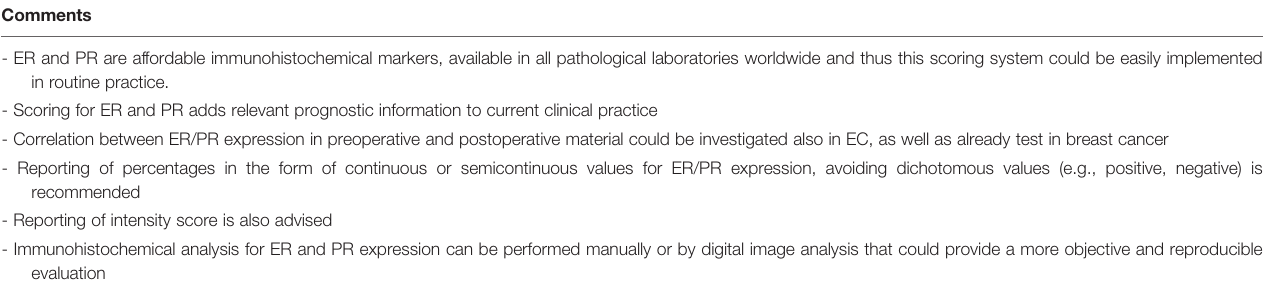
TABLE 4 | Hormonal receptors: comments from the working